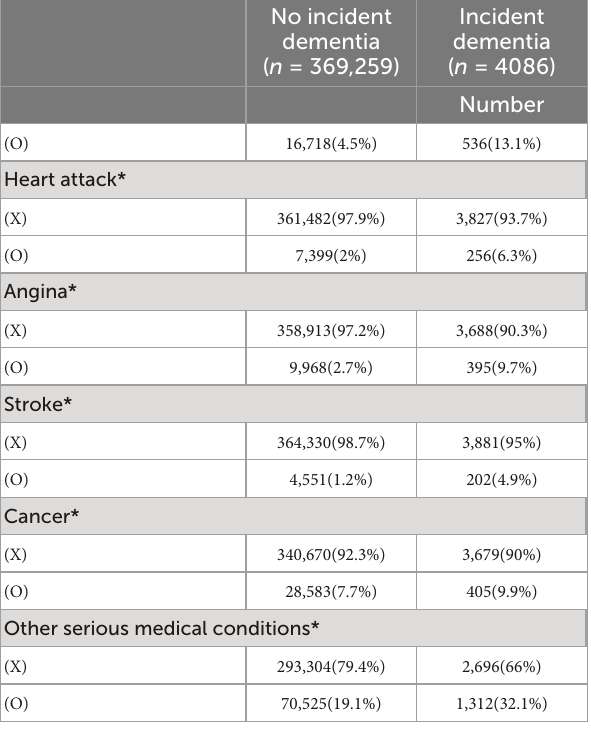
TABLE 1 Baseline characteristics of participants with and without incident